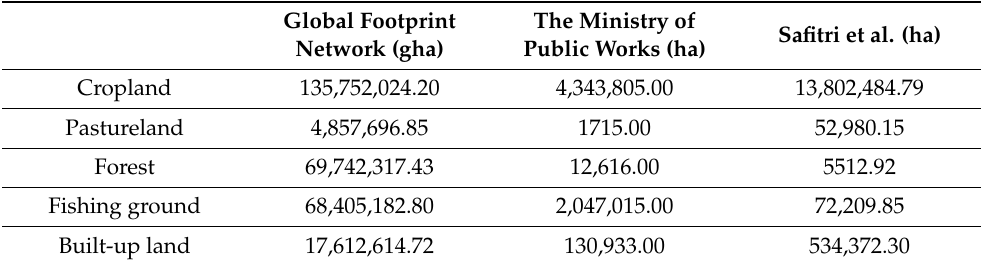
Table 14. The comparison of land requirements using the ecological footprint approach in this study with other